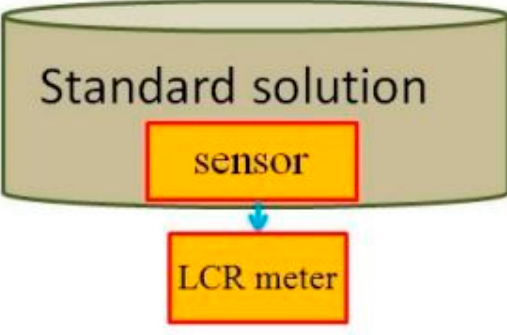
Figure 4. Schematic diagram of calibration of the flexible micro pH sensor.